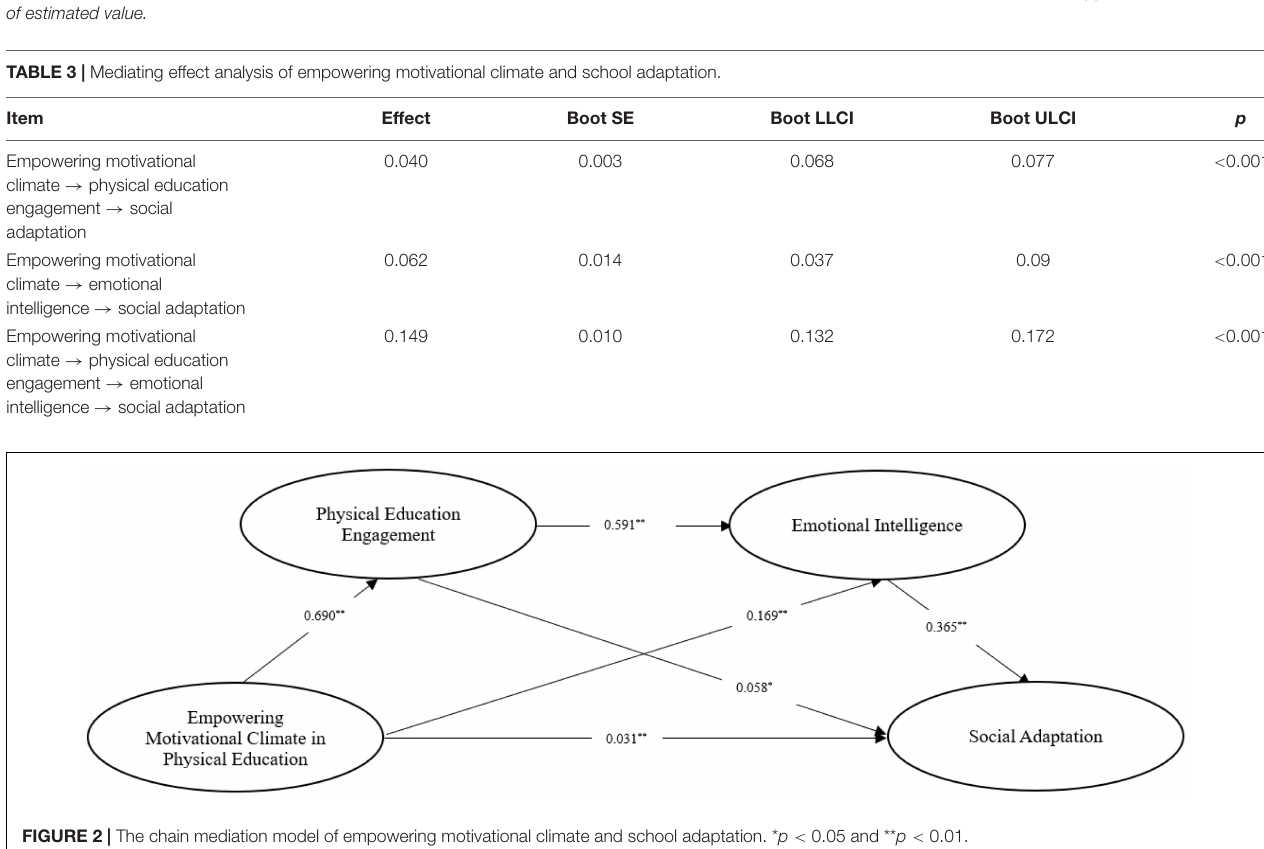
FIGURE 2 | The chain mediation model of empowering motivational climate and school adaptation. * p < 0.05 and ** p <